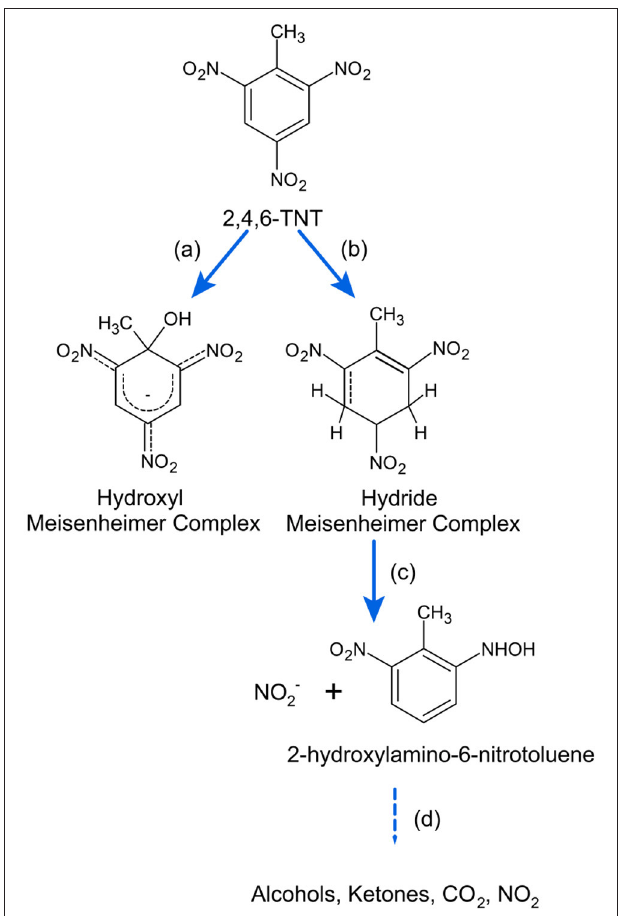
FIGURE 7 | TNT transformation and mineralization via Meisenheimer complex intermediates. Symbols as in Figure 6 . References: a, Lenke et al. (2000) and Mills et al. (2003); b, Symons and Bruce (2006), Lenke et al. (2000), Ziganshin et al. (2007), and Rieger et al. (1999); c, Williams et al. (2004) and Wittich et al. (2008) ; d, Williams et al.